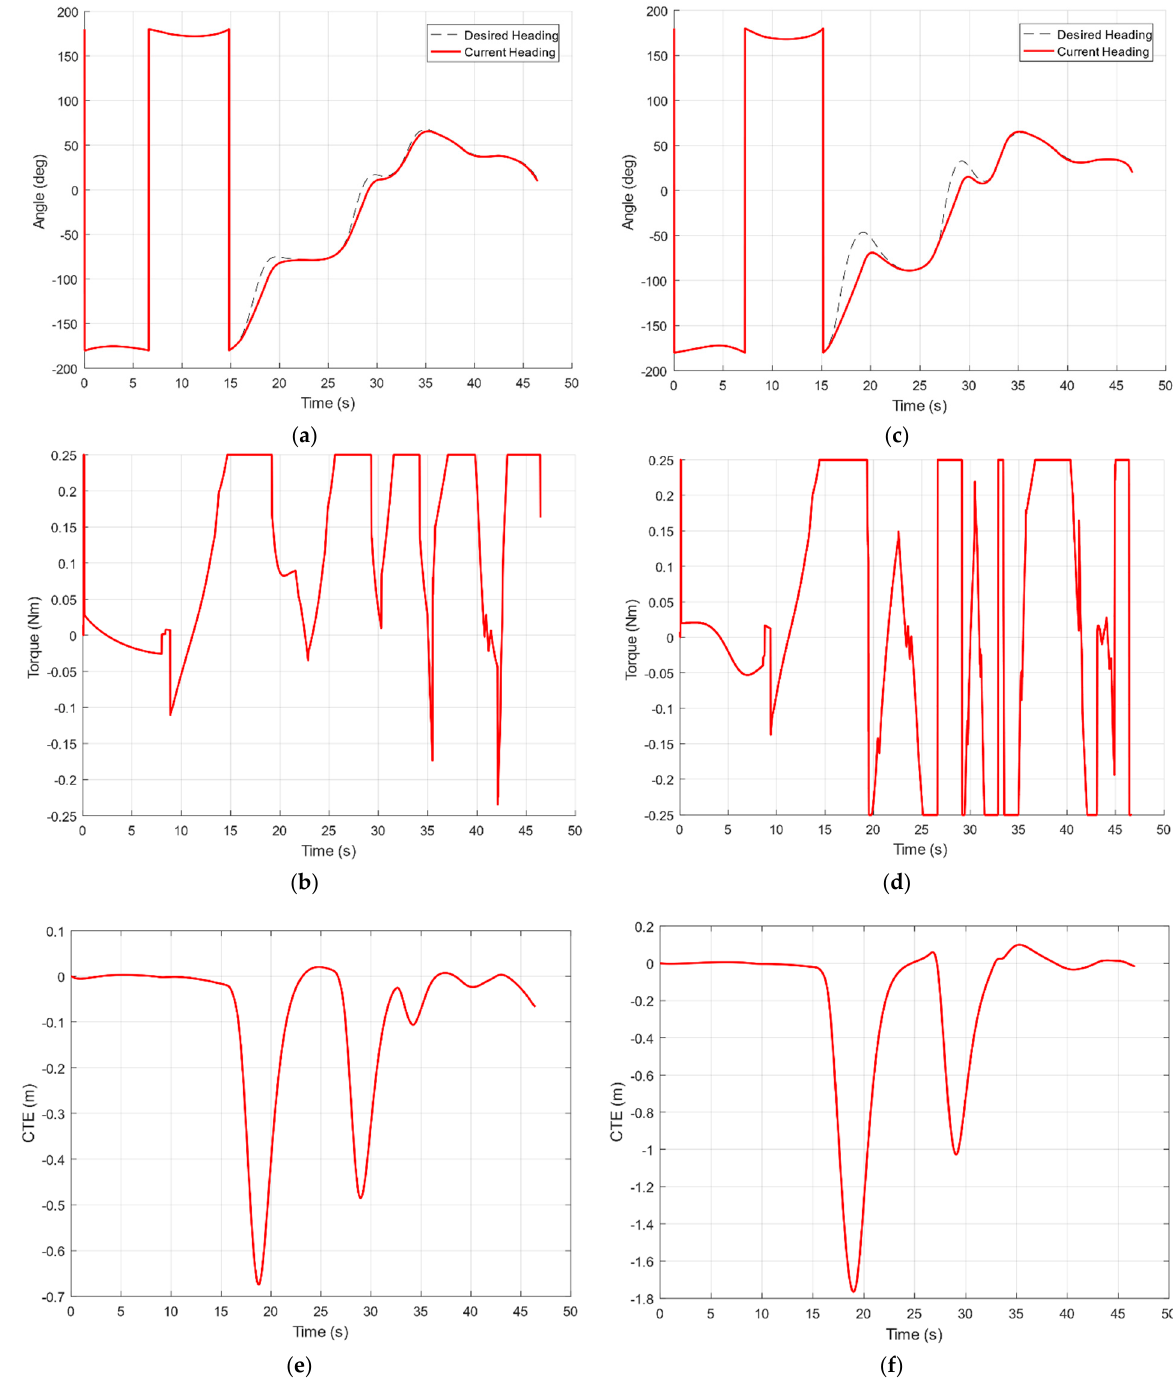
Figure 12. Comparisons of control and guidance performance for two cases in terms of heading error ( a , c ); control signal ( b , d ) and CTE ( e , f ). Table 4. Quantitative evalution in control and guidance performance for two cases.